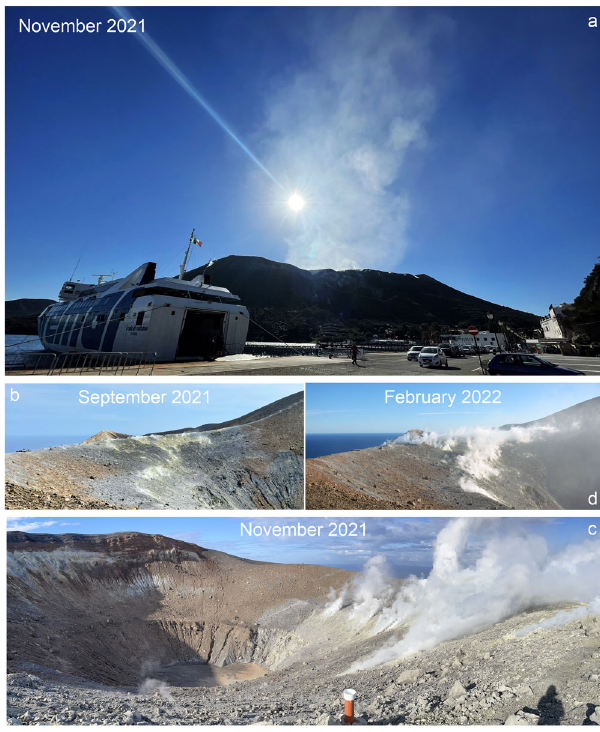
Fig. 1 Escalating degassing activity at La Fossa cone in 2021. a The La Fossa volcanic plume seen from the Vulcano Porto (harbour) area in November 2021; b to ( d ), evolution of the fumarolic fi eld, from September 2021, right before onset of the unrest ( b ), to during the unrest in November 2021 ( c ) and February 2022 ( d ) (Photos